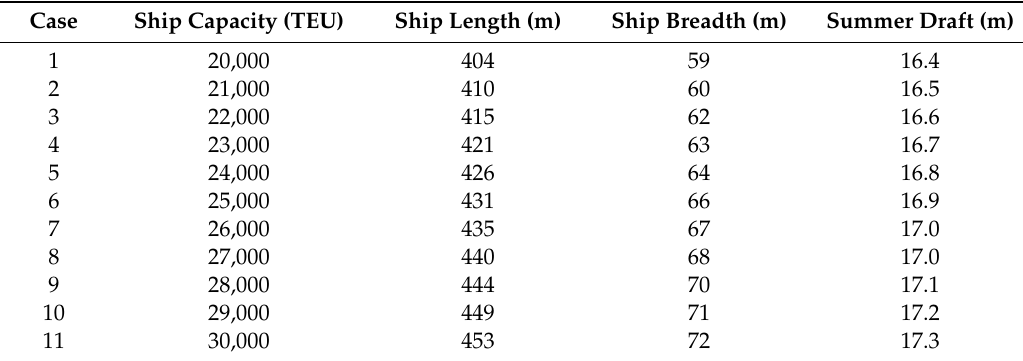
Table 6. Prediction of Vessel Dimension using Ship Capacity (TEU).